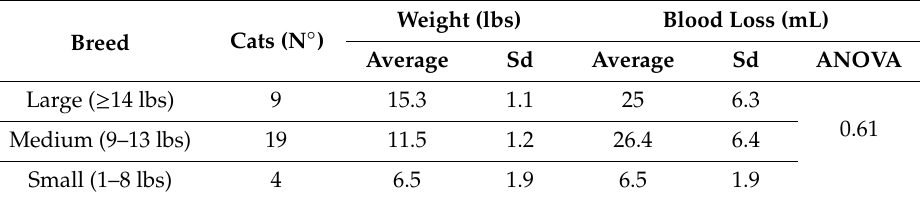
Table 4. Duration of surgical procedures.